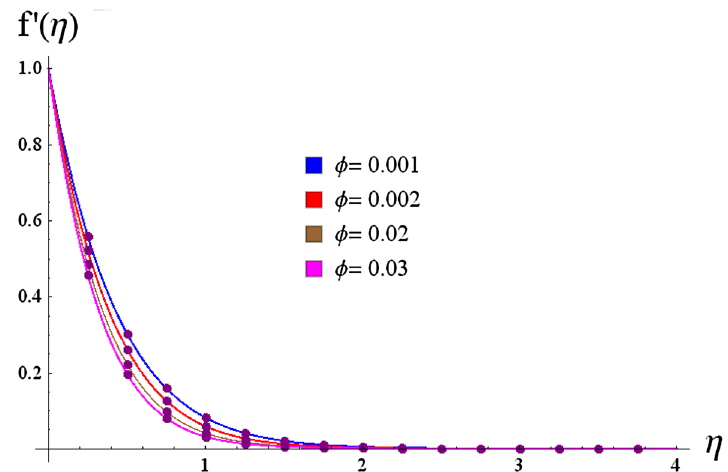
Figure 5. Behavior of velocity f ′ (η) against φ = 0.001, 0.002, 0.02, 0.03.